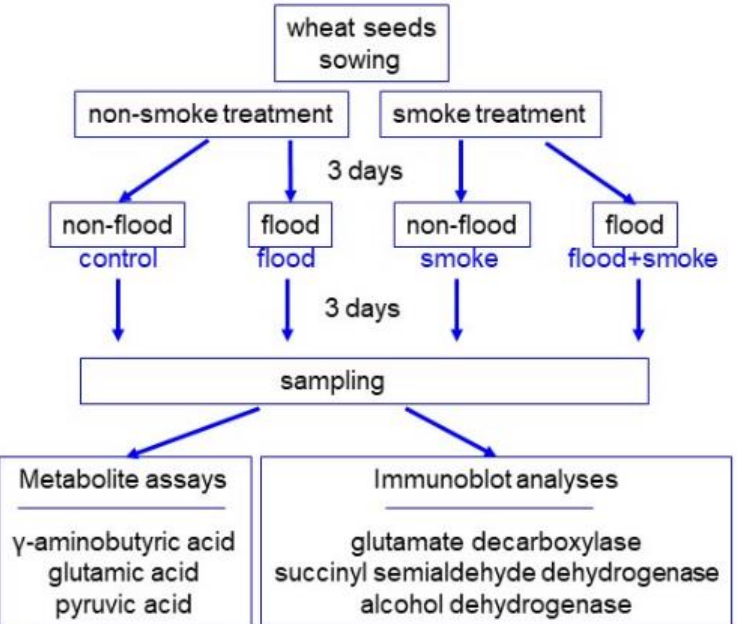
Figure 1. Experimental design for investigation of the effect of flooding stress on wheat. To investigate the potential positive or negative effects of flooding stress on wheat, seeds were sown and grown with or without flooding. Three days after sowing, wheat seedlings were flooded for 3 days. Additionally, because PDSS enhances wheat growth under flooding, wheat seedlings were treated with 2000 ppm PDSS. Wheat seedlings were analyzed using metabolite assays and immunoblot analyses. All experiments were performed with three independent biological replicates.